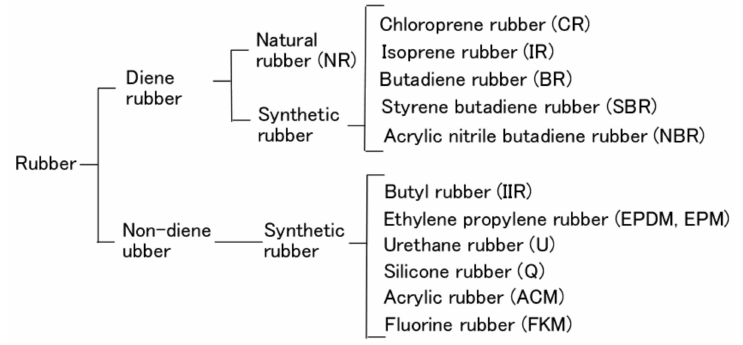
Figure A1. Classification of